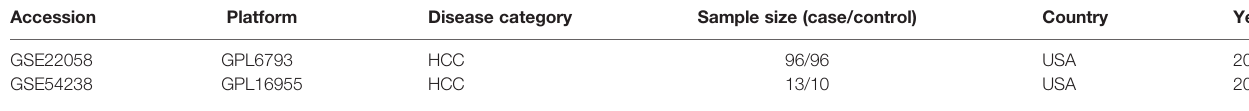
TABLE 1 | The acquisition of HCC microarray expression pro fi les.